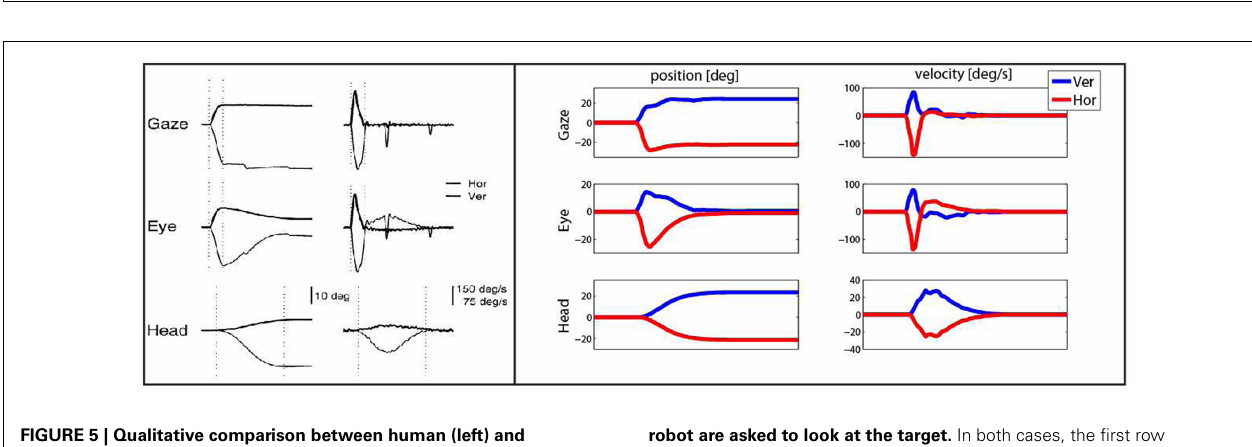
robot are asked to look at the target. In both cases, the first row represents the gaze response as result of the coordinated rotation of the head and the eye, which are illustrated in the second and third rows,